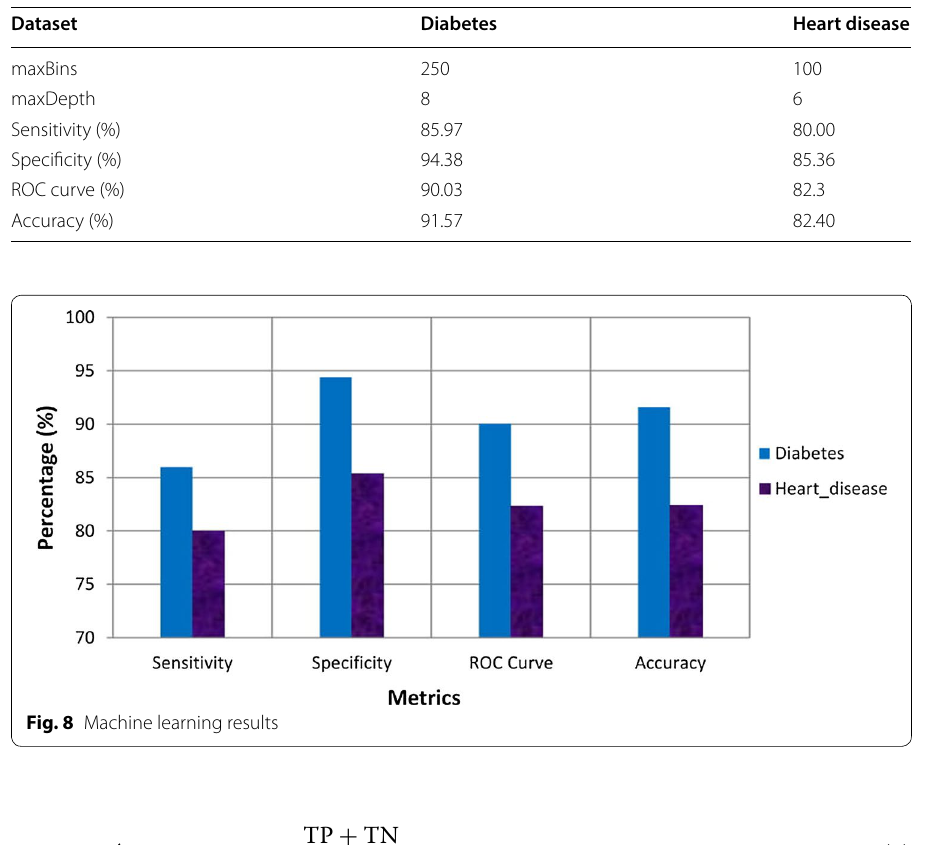
Table 5 Classification results